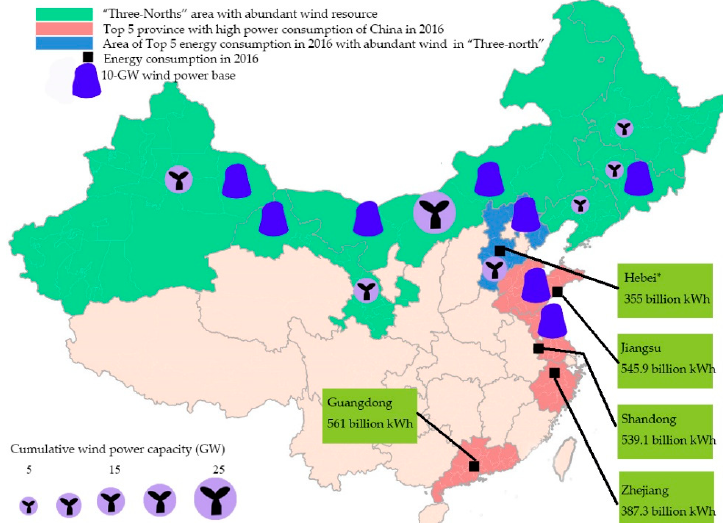
Figure 8. Wind resource and energy consumption distribution in China (Data source: location data of 10-GW wind power base is based on [24], data of cumulative installed capacity is integrated by [62] and Chinese Wind Power, data of energy consumption is collected from statistical data from the corresponding Provincial Bureau of Statistics. Magnitude of energy consumption of Hebei is predicted with data from January and August, 2016).